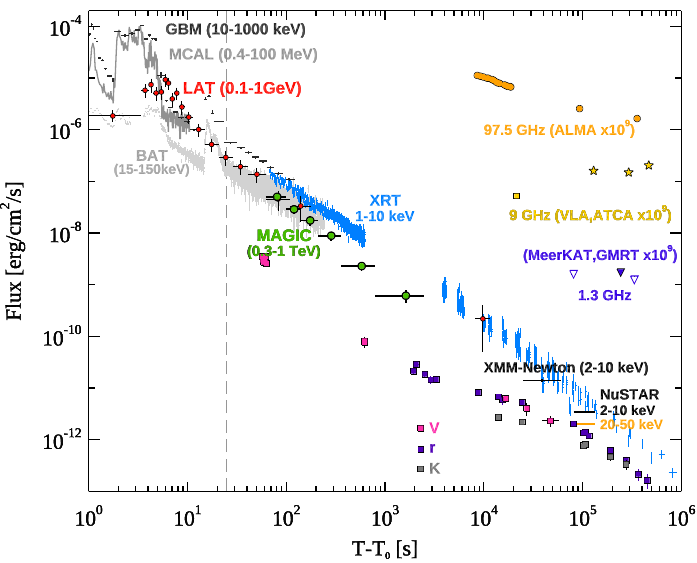
Figure 8. Radio to gamma-ray multi-wavelength light curves of GRB 190114C. The dashed vertical line marks the end of the prompt emission phase. Reprinted with permission from Ref.